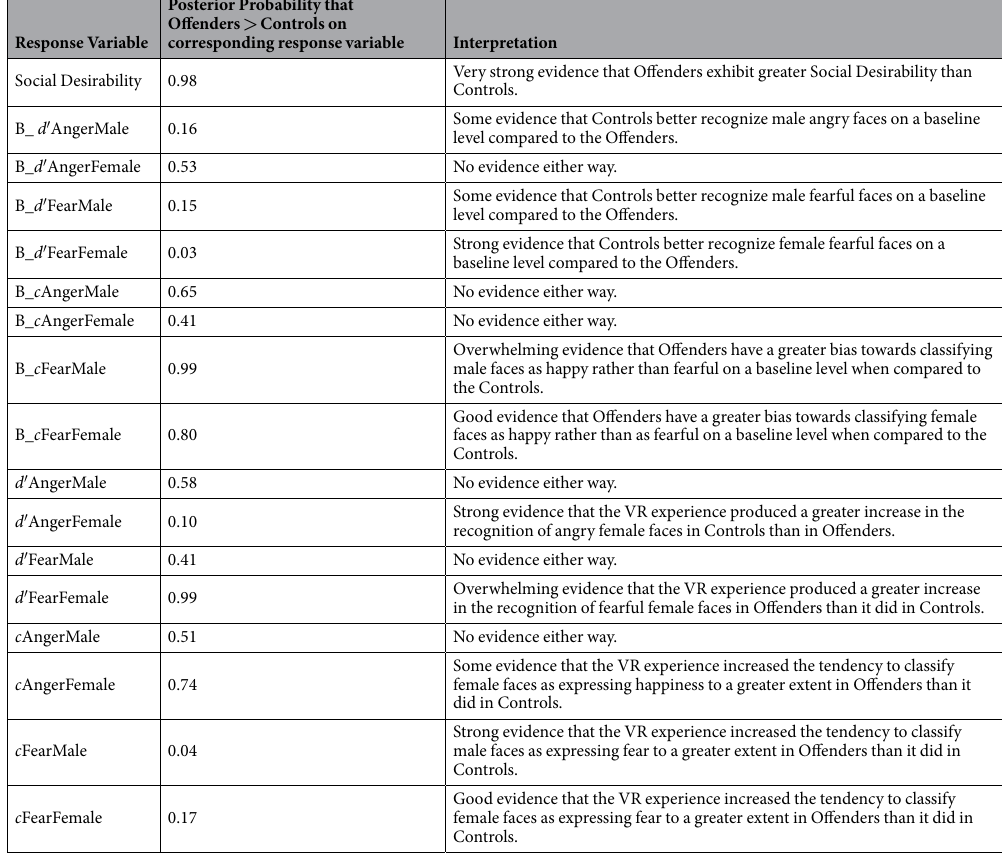
Table 2. Posterior Probabilities that the Offenders and the Control groups differed in social desirability and in emotion recognition before (B) the immersive virtual reality (VR) experience and the change afterwards (post- pre). Bayesian statistical model using Group as the independent variable. B, baseline (before VR); c , bias towards classifying faces as expressing a particular emotion; d ′ , sensitivity to recognize a particular facial